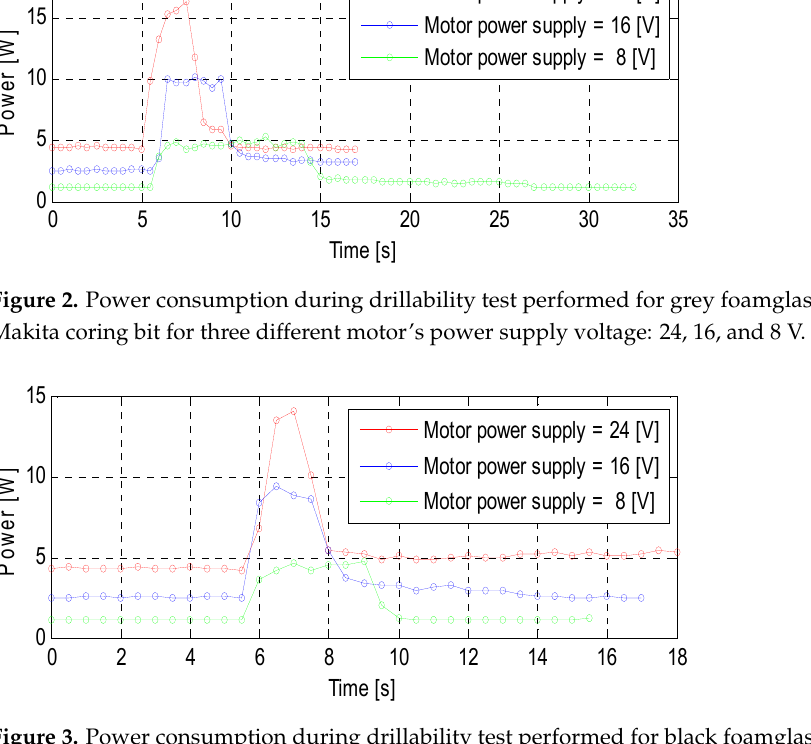
Figure 4. Power consumption during drillability test performed for white foamglas S sample using Makita coring bit with motor’s power supply voltage 24 V. WOB = 27.27 N. For sample 4, drillability tests were performed with the same Makita coring bit, 27.27 N weight on bit (WOB) and with motor power supply 24, 16, 8 V. Material was harder, drilling process a little slower, thanks to which the drilling speed could be measured. For 24, 16, 8 V motor power supply, the coring bit was moved into the material at a depth of 55 mm in 29.7 s, 53 mm in 50 s, and 53 mm in 80 s, respectively. After reaching specified depths, like in previous samples, the drilling process was hindered because the tool was stopped by the upper face inside the coring bit. Power consumption and drilling speed were presented in Figures 5 and 6, respectively. In this sample, the effect of energy used on grinding non-removed cuttings is more visible. The drop of drilling speed caused by this effect can be observed in Figure 6.